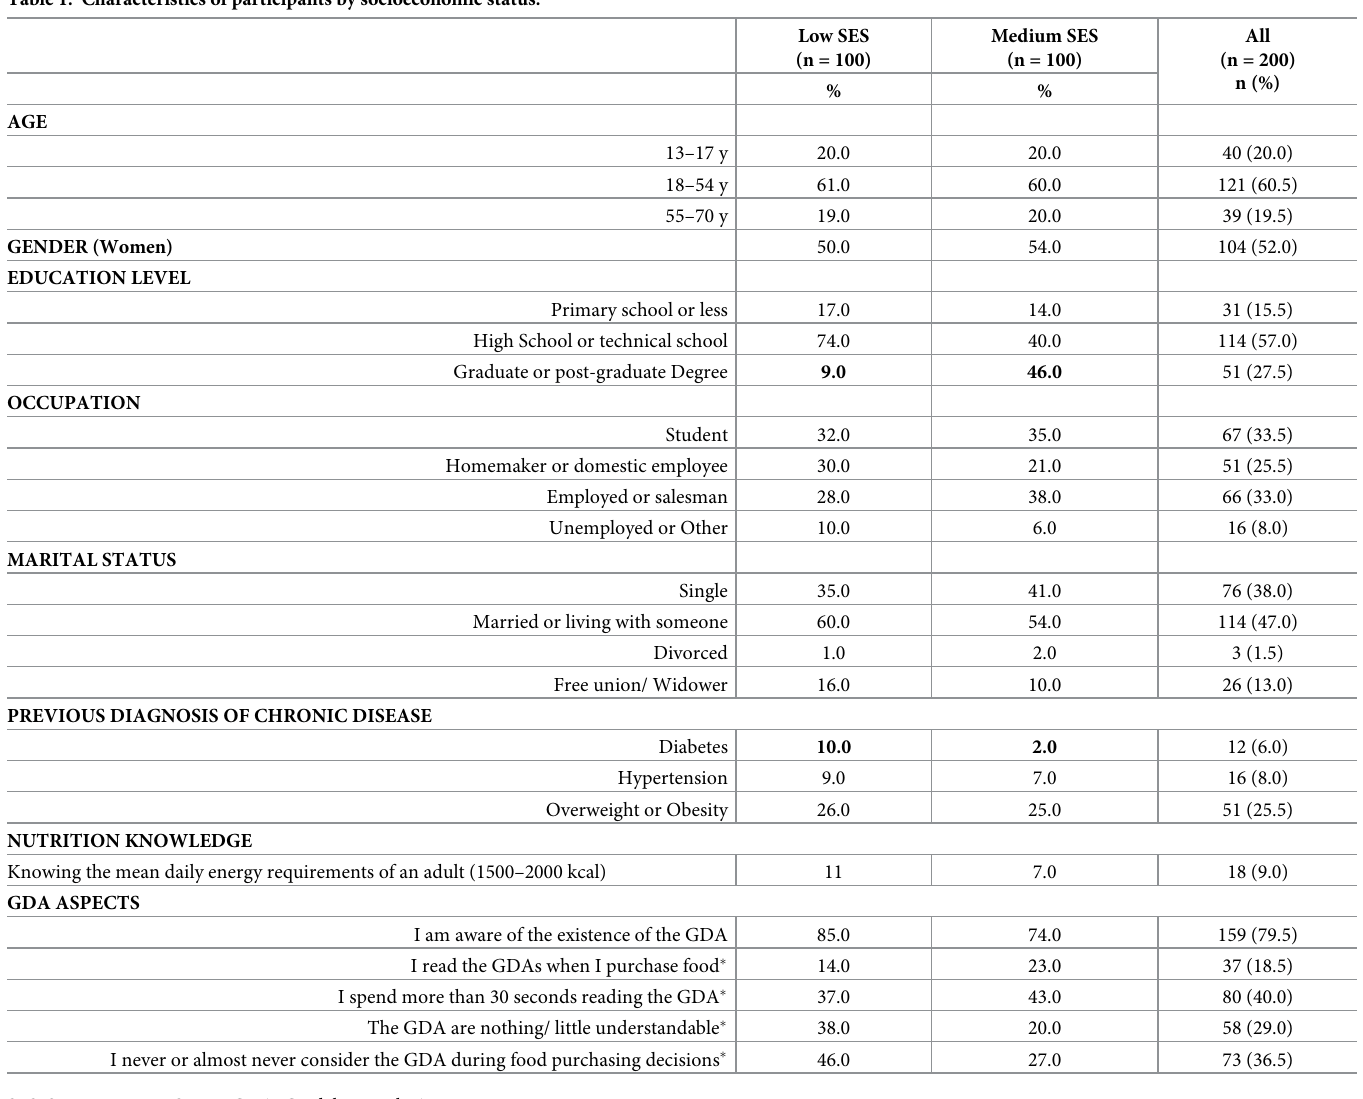
Table 1. Characteristics of participants by socioeconomic